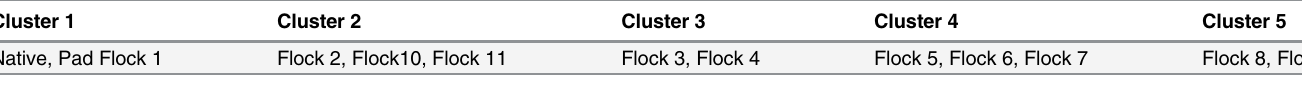
Table 2. Sample classes in each canonical discrimination cluster.